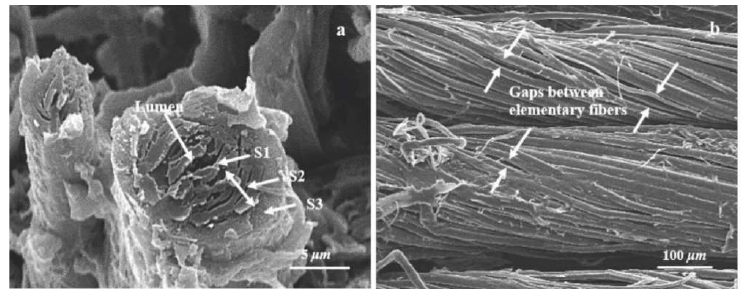
Figure 1. ( a ) Cross-section of an elementary flax fiber and ( b ) flax fiber yarns.